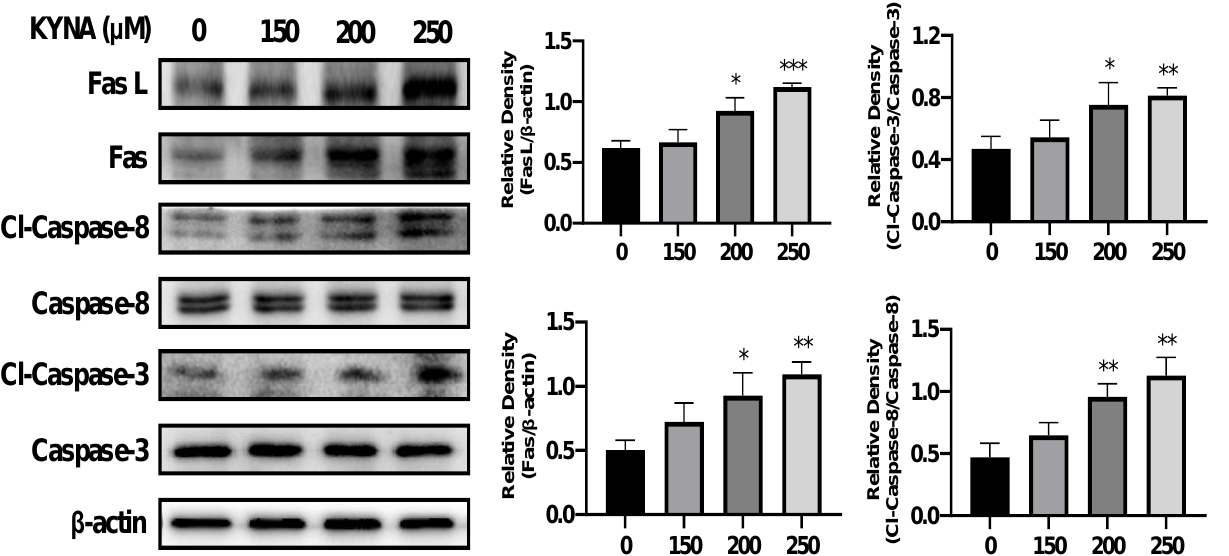
Figure 8. KYNA induced extrinsic apoptosis pathway of AGS cells. The cells were treated with KYNA at indicated concentrations (0, 150, 200, and 250 µ M) for 24 h. Fas ligand (FasL), Fas, cleaved caspase-8, and cleaved caspase-3 levels were quantified by western blot. The results obtained from three independent experiments were expressed as mean ± standard error of the mean (SEM) compared with the control group. * p < 0.05, ** p < 0.01, *** p < 0.001.